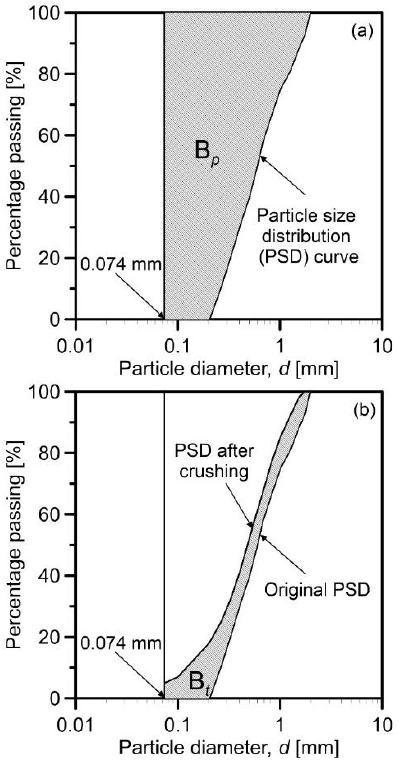
Fig. 1. Hardin’s [8] breakage parameters. (a) Breakage potential ( B p ), and (b) total breakage ( B t